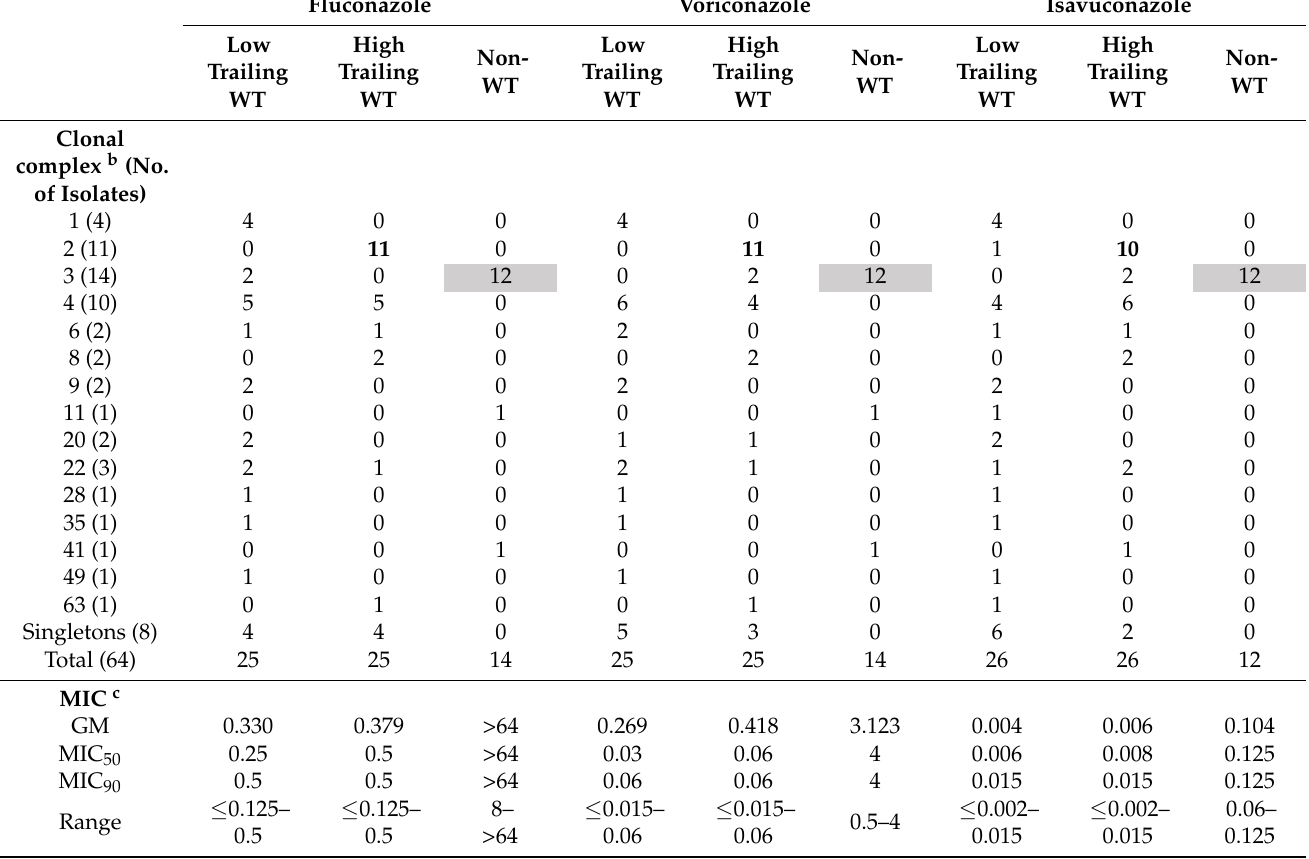
Table 2. Distributions of low and high trailing wild-type, and non-wild-type Candida tropicalis isolates, and their corre- sponding clonal complexes a and minimum inhibitory concentrations